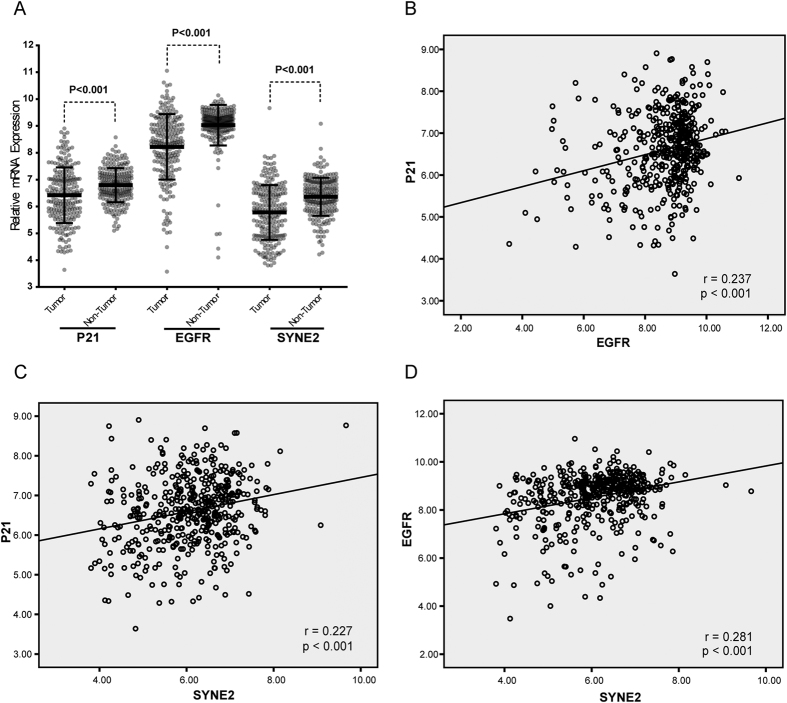
(A) Scatter diagram for mRNA expression of p21, SYNE2 and EGFR between HCC tissues and adjacent normal tissues (all P < 0.001). (B) Correlation analysis for the mRNA expression between p21 and EGFR (P < 0.001, r = 0.237). (C) Correlation analysis for the mRNA expression between p21 and SYNE2 (P < 0.001, r = 0.227). (D) Correlation analysis for the mRNA expression between EGFR and SYNE2 (P < 0.001, r = 0.281). All data were from Gene Expression Omnibus (GEO accession: GSE14520).